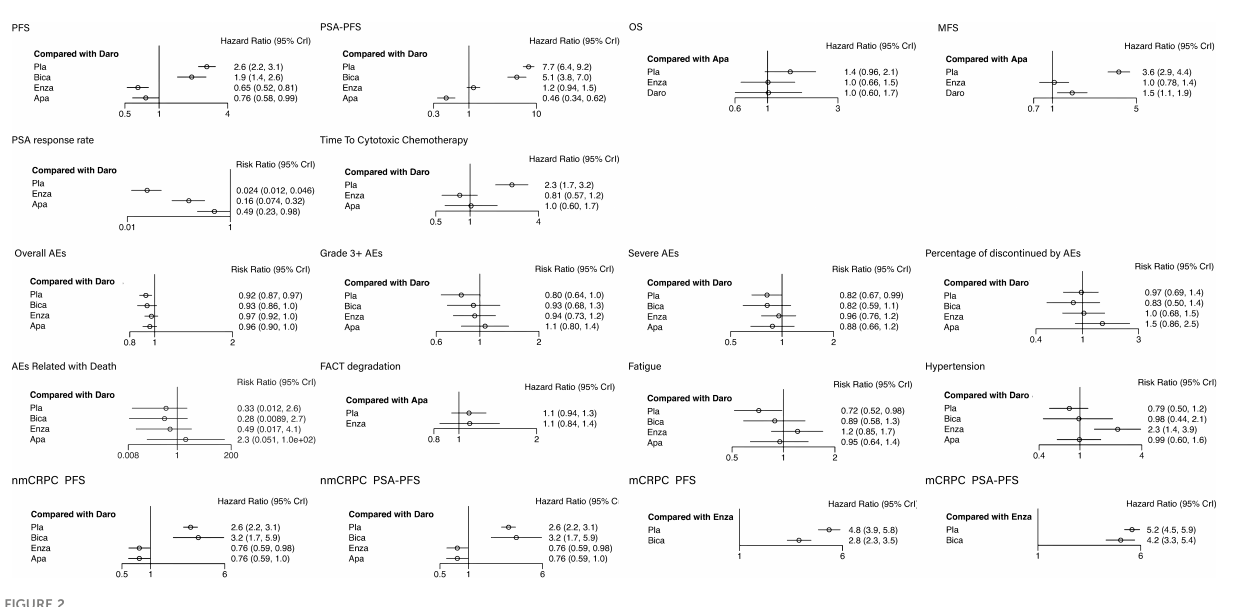
FIGURE 2 The forest plots of outcomes. The vertical line in the middle is an invalid line, OR=1, indicating that there is no statistical signi fi cance between the interventions and the outcomes; The dot is the point estimate of the OR value of each study included; The horizontal line of represents the 95% con fi dence interval of the OR value.